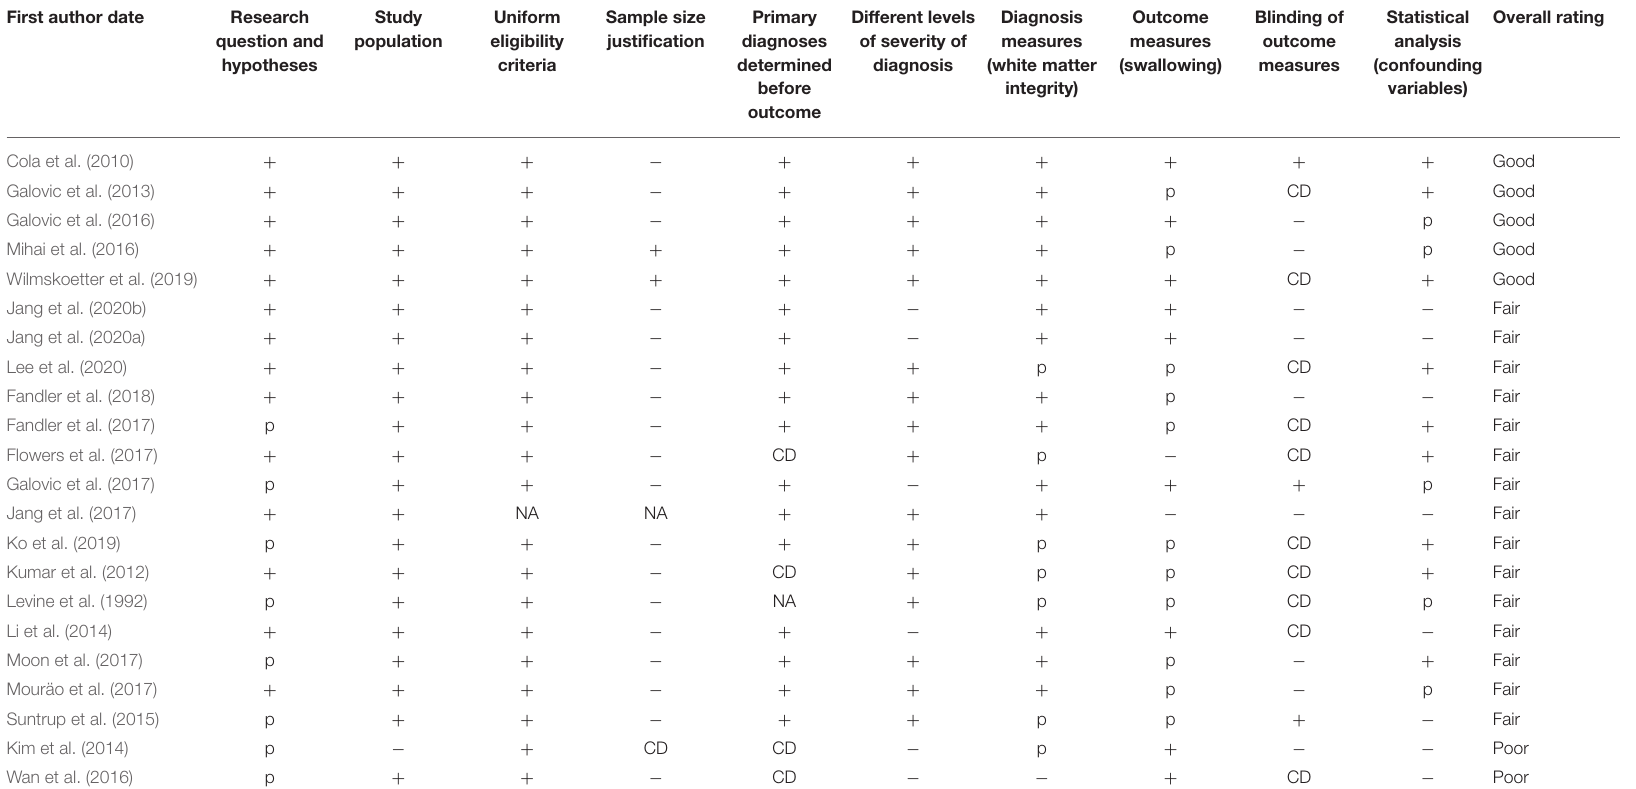
TABLE 1 | Study quality parameters rated using the modified NIH quality assessment for observational cohort and cross-sectional